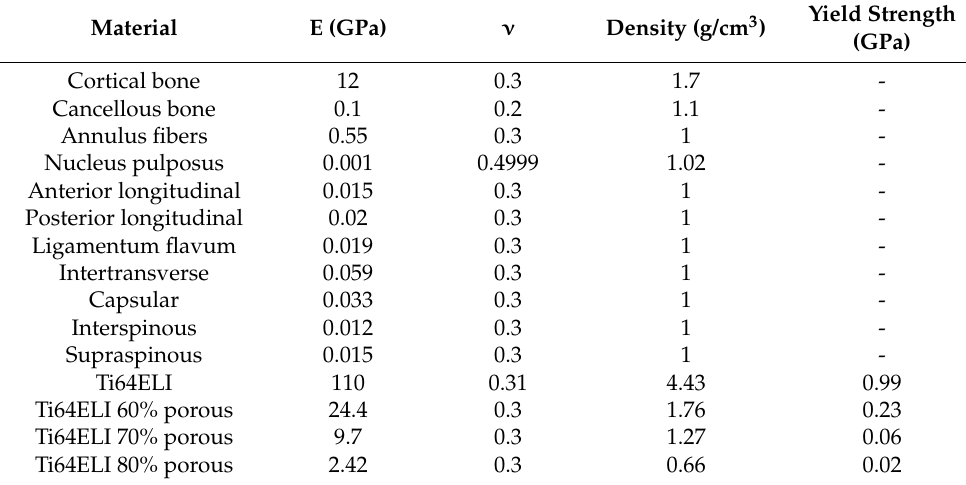
Table 1. The material properties for